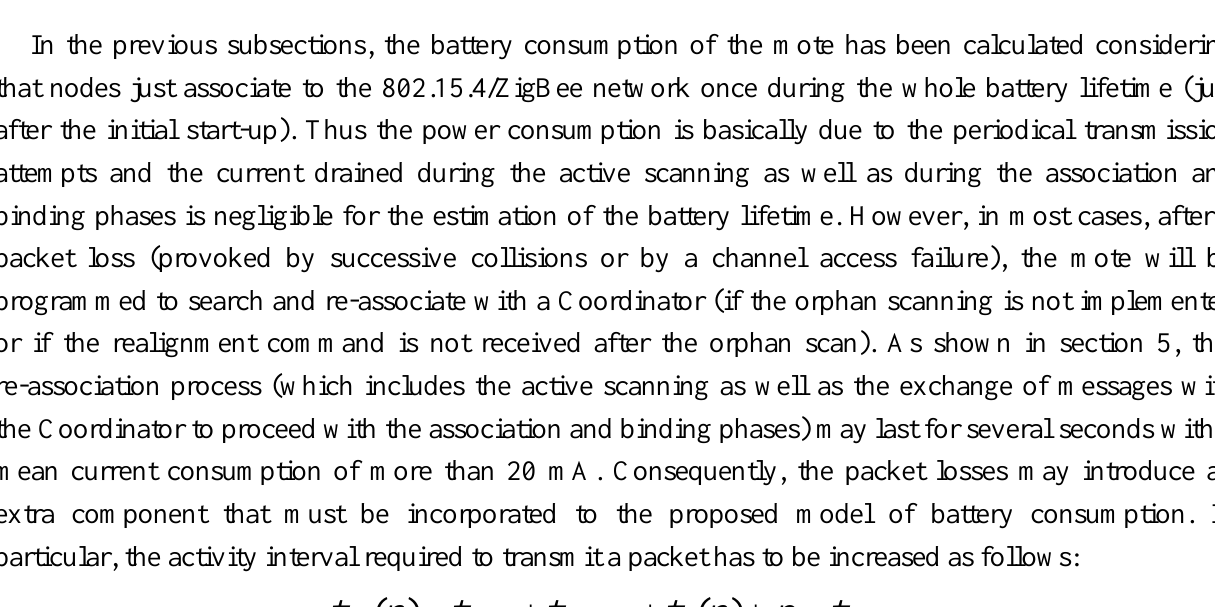
) and packet collision ( p ) (battery capacity o c